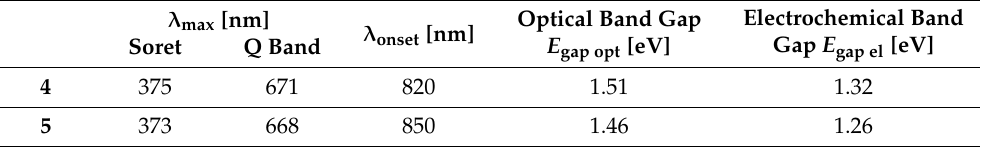
Table 2. The optical and electrochemical HOMO-LUMO band gaps for porphyrazines 4 and 5 . λ max [nm]